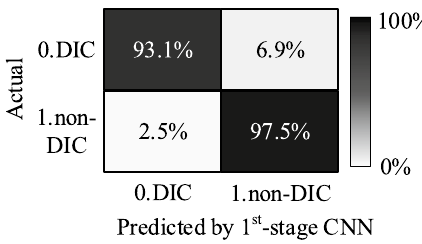
Figure 9. Identification accuracy of the first-stage CNN